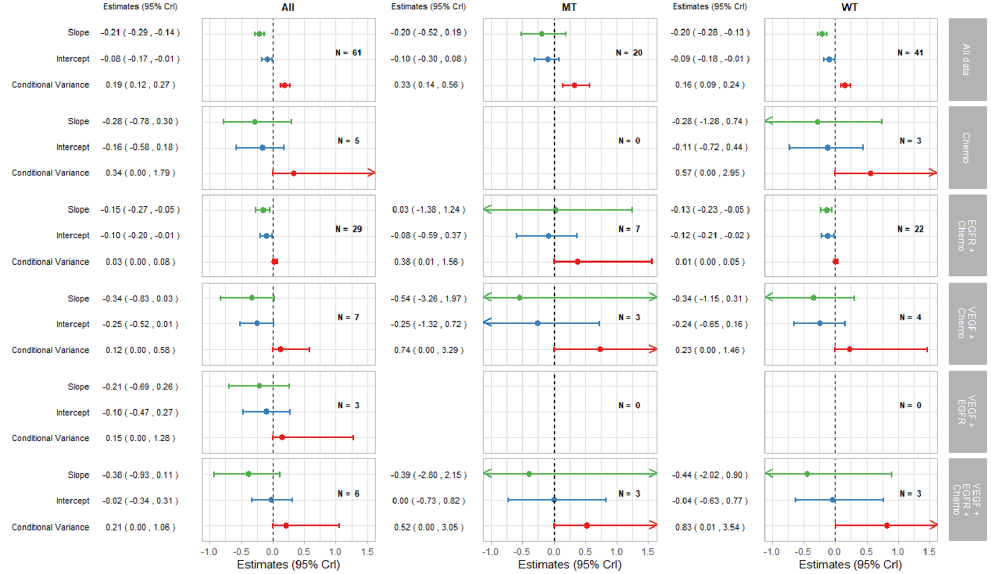
Figure 4. Forest plot of estimates of slope (green), intercept (blue), and conditional variance (red) for TR as a surrogate for PFS. N represents the number of